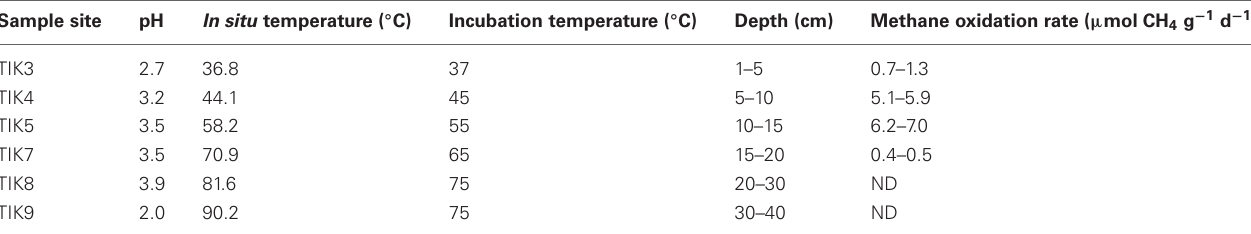
Table 1 | Physiochemical properties and methane oxidation rates of Tikitere soil profile samples TIK3–9. Sample